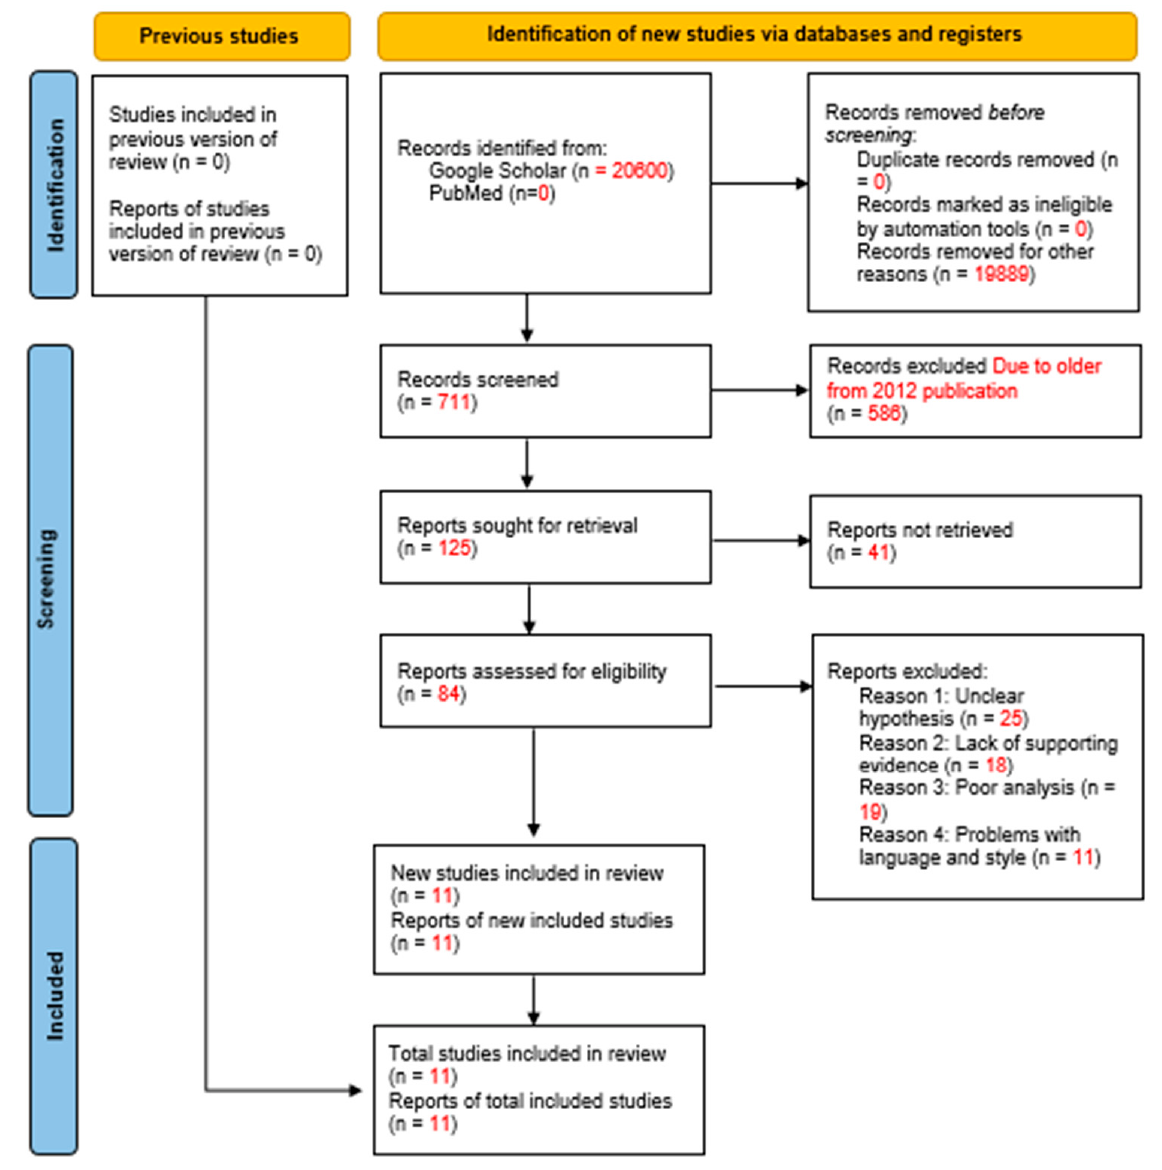
Figure 2. PRISMA for the second category (Expert Systems and NDs) .